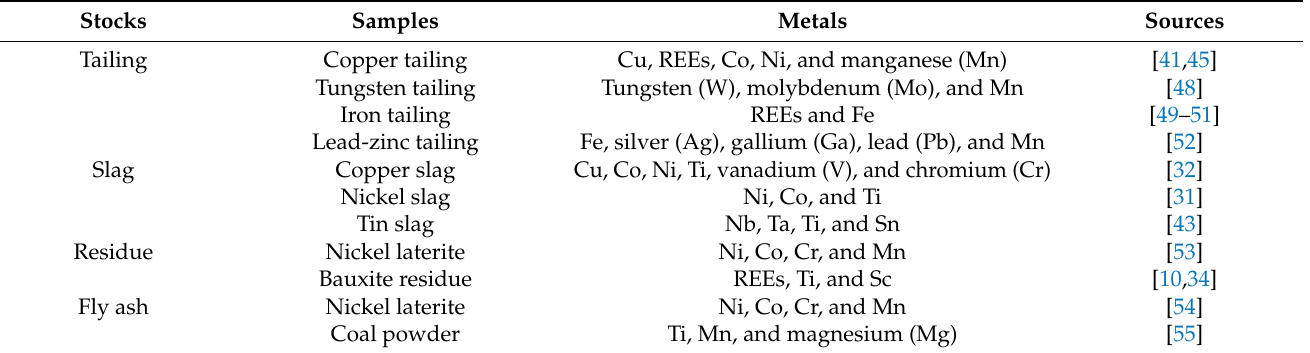
Table 2. Valuable elements that can be recovered from technospheric stocks from the mining